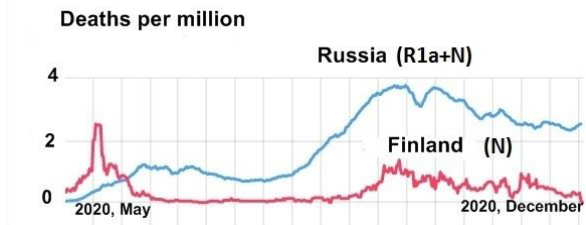
Figure 7. Dynamics of mortality in haplogroups R1a and N before the start of mass vaccination, per 1 million (based on the Johns Hopkins University data). Blue line – Russia (dominant haplogroup R1a+N); pink line – Finland (dominant haplogroup N)